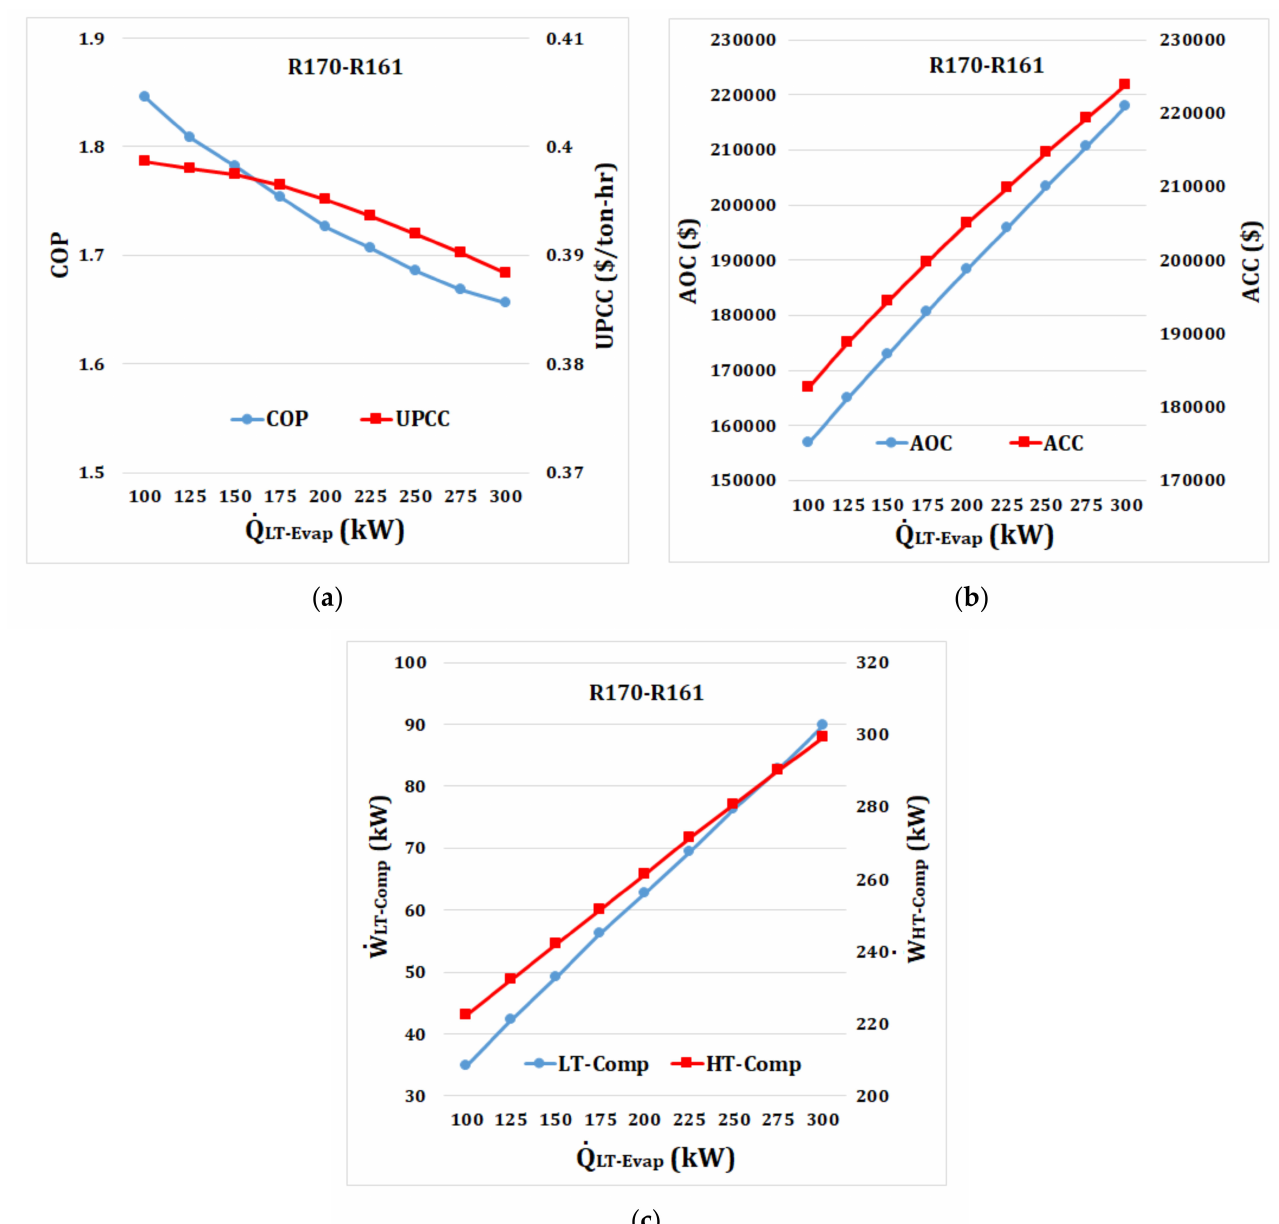
. Q LT − Evap on ( a ) COP and UPCC, ( b ) AOC and ACC, and ( c ) Figure 13. Effect of cycle using R170-R161 refrigerant